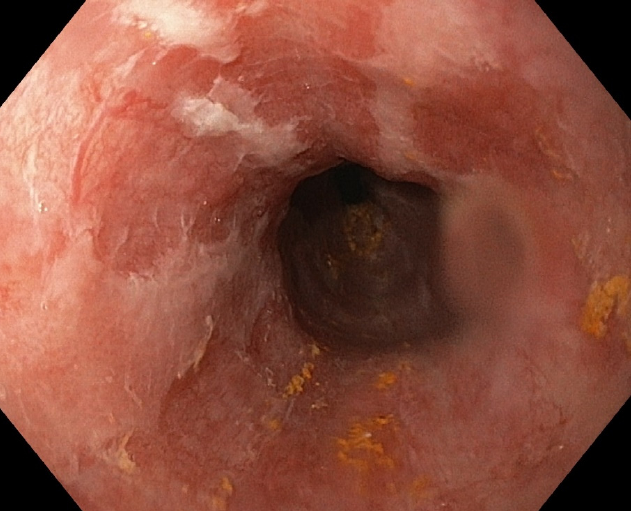
Figure 5. Second look-up showed white exudates covering the esophageal mucosa, just one week after the first endoscopy. The evolution was slowly resolving: the initial hypovolemia was corrected with vasopressor support and vigorous fluid resuscitation. Given the Cl. difficile history and previous antibiotic ther- apy for biliary affliction, the infectious disease specialist recommended initial antibiotics that later were adjusted for Pseudomonas aeruginosa urinary infection sensitive to Colistin. The pancreatitis had a favorable evolution and the patient was treated conservative with PPI and parenteral nutrition until after the endoscopic second look. The oral nutrition was initiated with liquids, the patient con- dition improved significantly, and the patient was discharged. The patient did not present for fol- low-up. The clinical presentation of patients with black esophagus is in most cases represented by